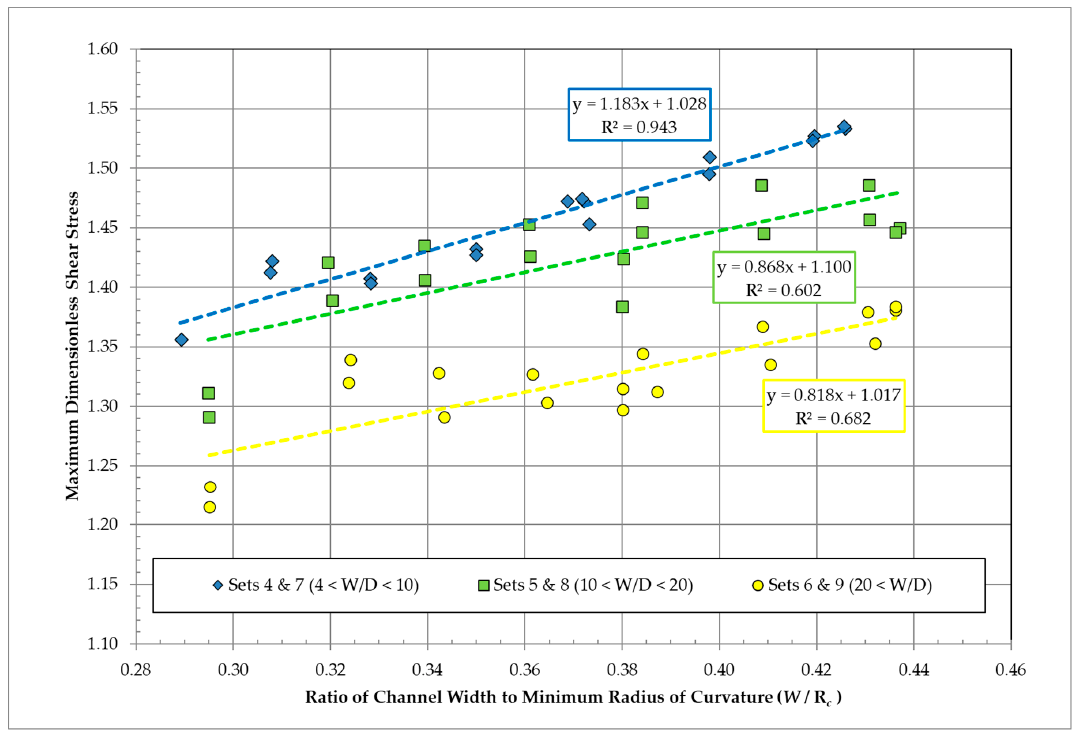
Figure 45. Correlations, using 6 simulations sets, between the maximum dimensionless near-bank shear stress and the ratio of channel top width to minimum radius of curvature.